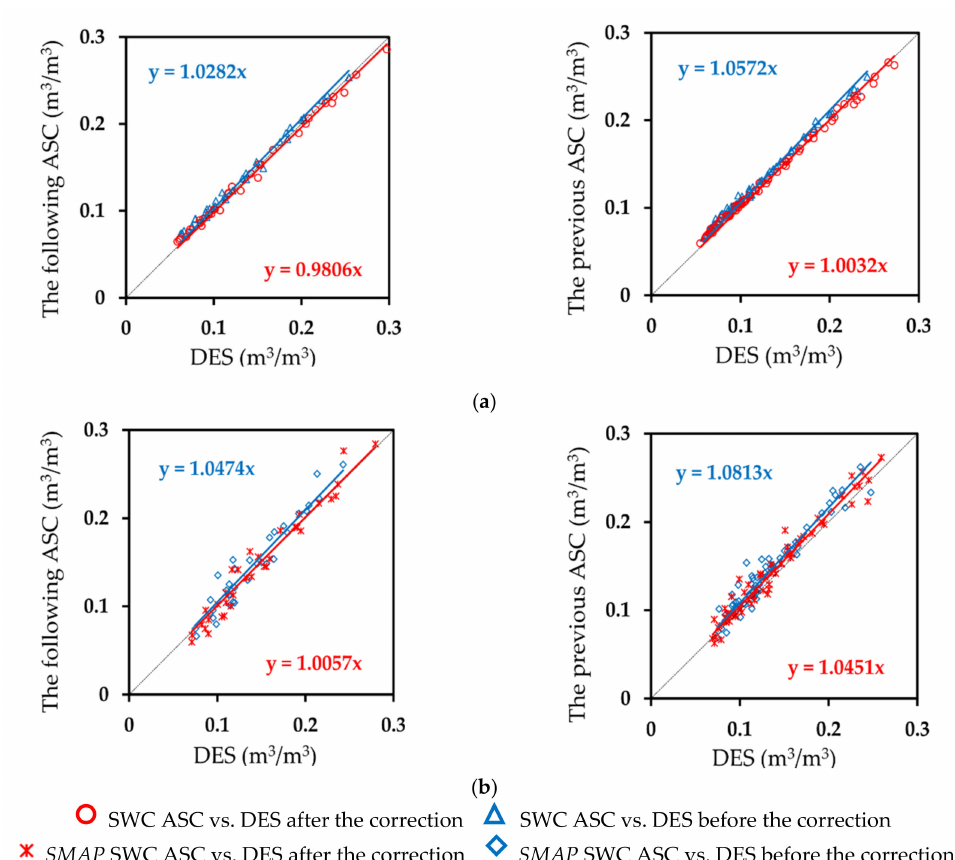
Figure 6. Scattergrams of ( a ) the previous and following ascending and descending soil moisture values of the in situ data, and ( b ) the previous and following ascending and descending soil moisture values of satellite data at LWREW from November 2017 to December 2019. The red color represents the corrected data in the figure, and the blue one denotes the initial